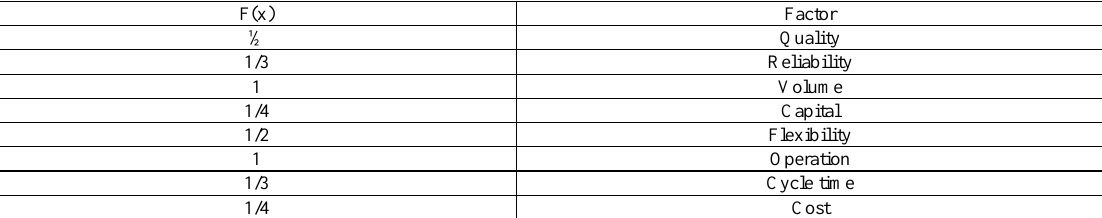
Table 2. Derived F(x) from the Equation (2)